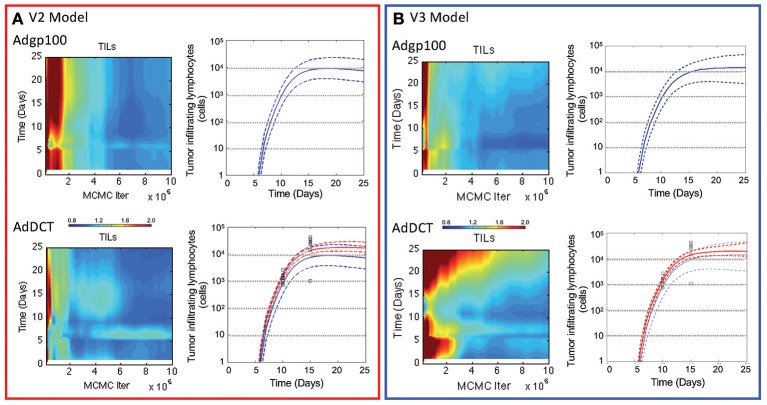
Comparison of the number of tumor infiltrating lymphocytes in V2 vs. V3 models. The number of CD8+ T lymphocytes infiltrating into implanted B16F10 tumors were simulated using the V2 (A) and V3 models (B). Convergence of the model predictions as a function of the Markov Chain length were assessed using the Gelman-Rubin potential scale reduction factor (left subpanels). The posterior distribution in the model predictions obtained from the converged segments of the Markov Chains are represented by a solid line, which represents the median response, and dashed lines that enclose the 95% credible interval (right subpanels). Simulated values are compared against the number of tumor infiltrating lymphocytes (squares) that were quantified 10 and 15 days in tumors following implanting subcutaneously of 1 × 106 B16F10 tumor cells and immunizing C57Bl/6 mice with DCT adenovirus on day 5 (bottom panels and red curves). The number of TILs were also simulated in mice immunized with rHuAd5-hgp100 (top panel and blue curves).